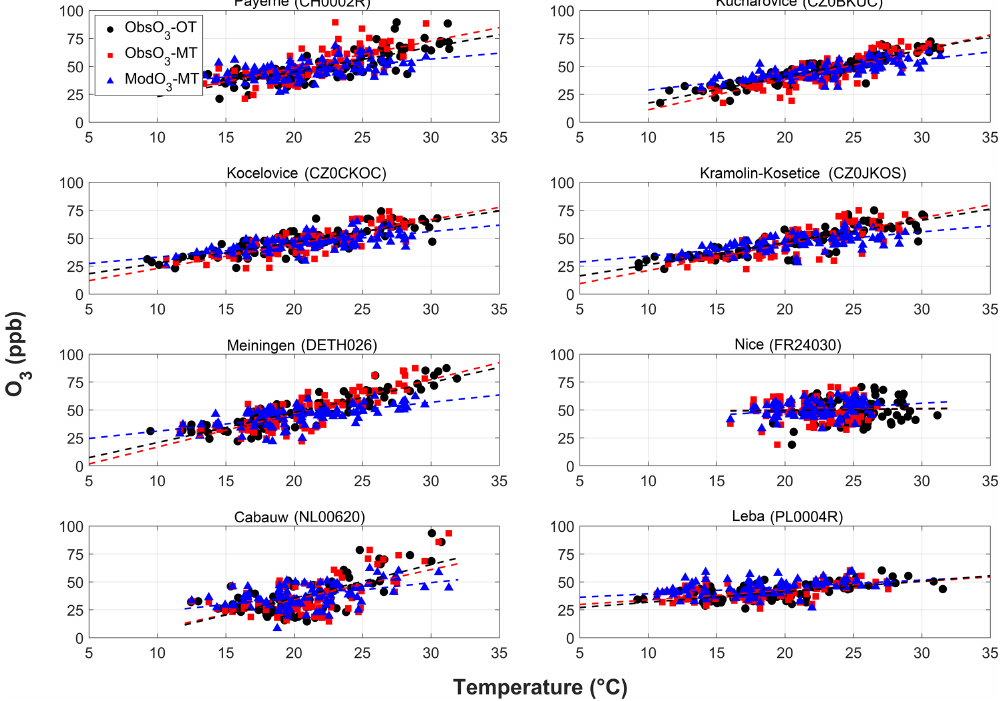
Figure 7. Scatterplots of surface afternoon (12:00–18:00UTC) mean O 3 mixing ratios vs. temperature for eight stations in summer 2010. Observed O 3 mixing ratios are plotted against both observed (ObsO 3 -OT) and modeled (ObsO 3 -MT) temperature, while the modeled O 3 mixing ratios are plotted only against the modeled temperature (ModO 3 -MT). Dashed colored lines represent the best linear fit for each